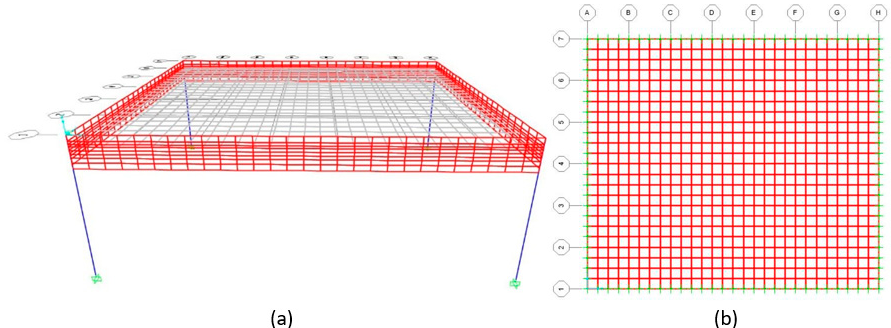
Figure 15. Finite element meshes for ( a ) beam and ( b ) slab models.